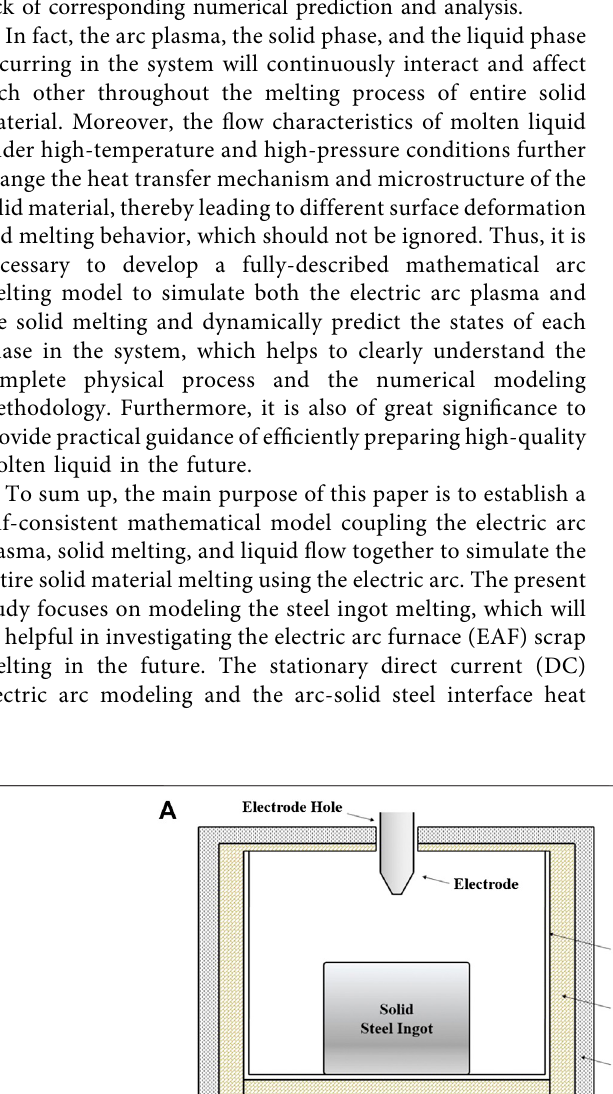
Frontiers in Materials |